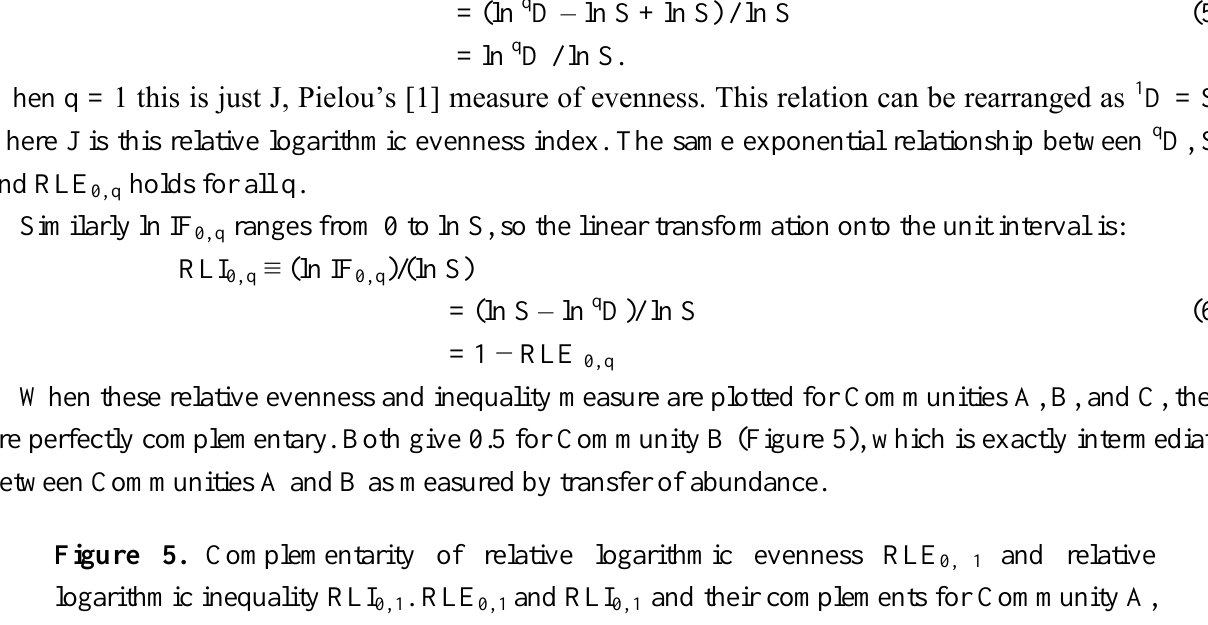
. RLE and RLI and their complements for Community A, 0, 1 0, 1 0, 1